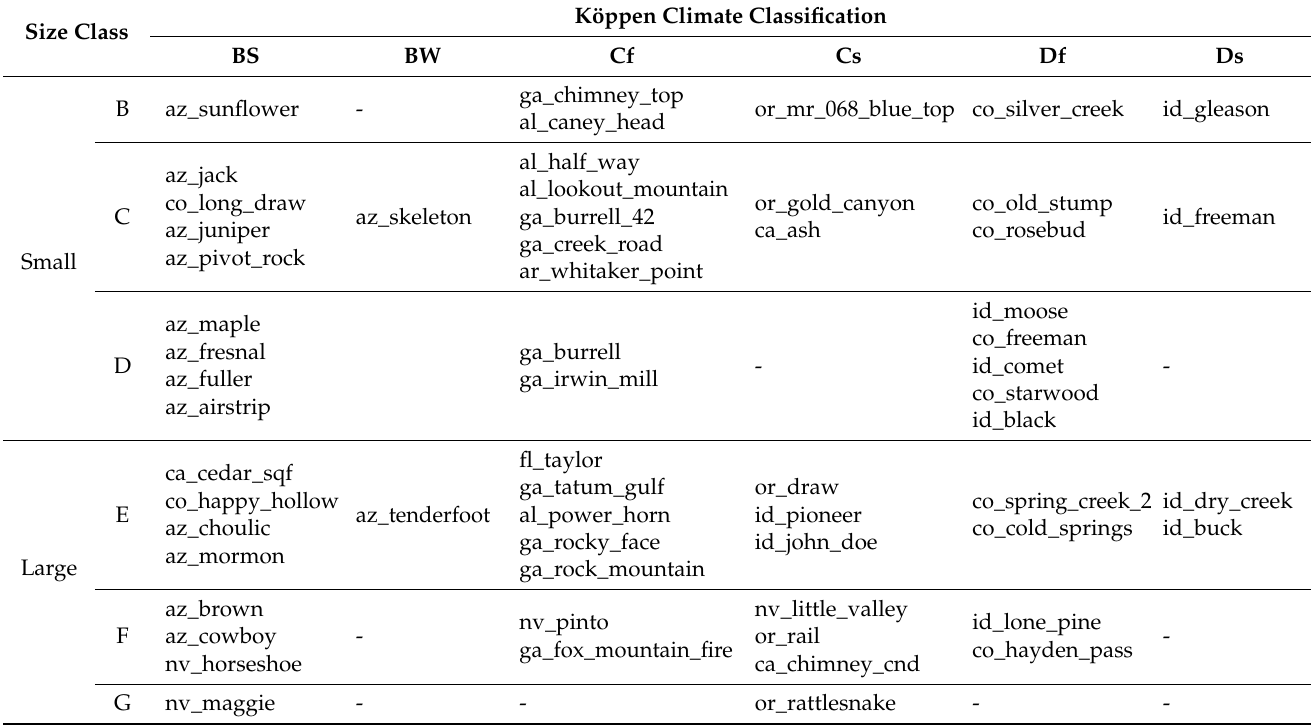
Table 4. Real data-based wildfire scenarios by Köppen climate classification and size class